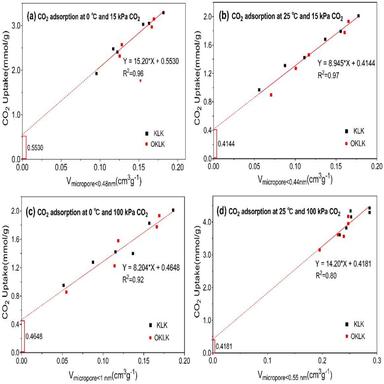
Relationship between CO2 uptake and ultra-micropore volume of the Kraft lignin carbons (a) ≤ 0.48 nm, 15 kPa CO2 and 0 ◦C; (b)≤ 0.44 nm, 15 kPa CO2 and 25 ◦C; (c) ≤ 1 nm, 100 kPa CO2 and 0 ◦C; (d) ≤ 0.55 nm, 100 kPa CO2 and 25 ◦C.